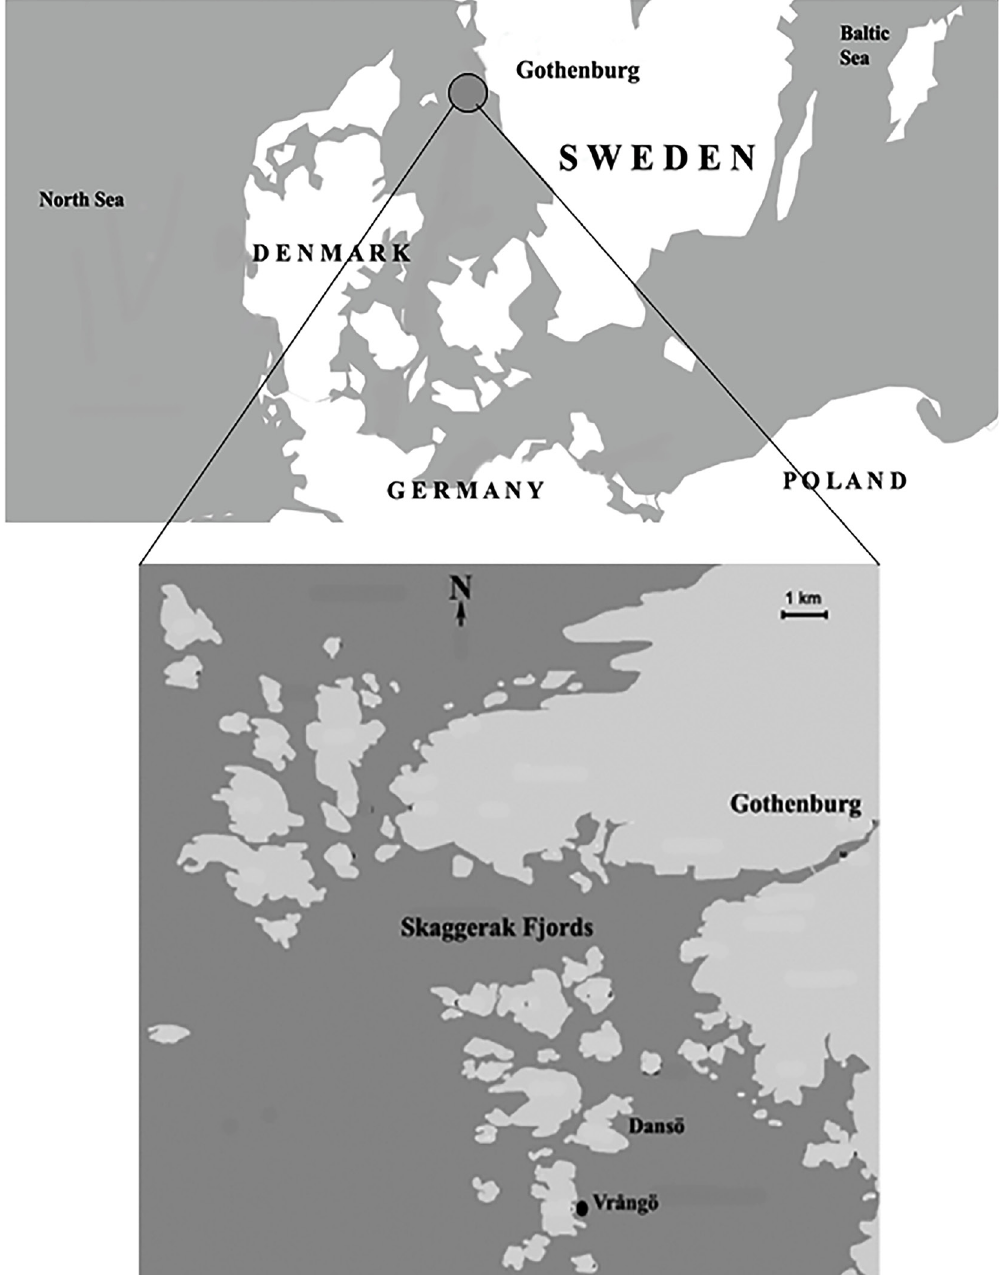
Fig. 1. Map of the west coast of Sweden and location of sampling site, Vrångö Island (black